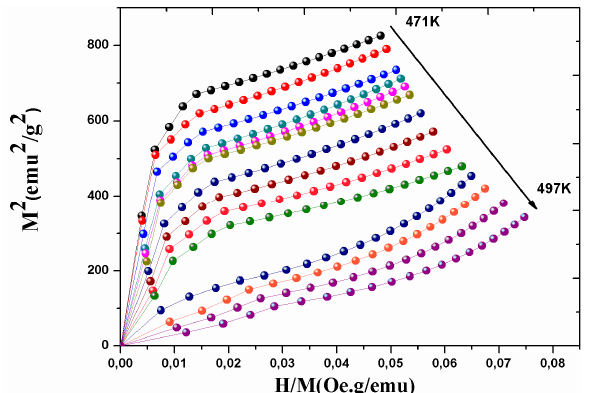
Figure 6. Arrott curves for Er 6 Fe 23 intermetallic (as an example).